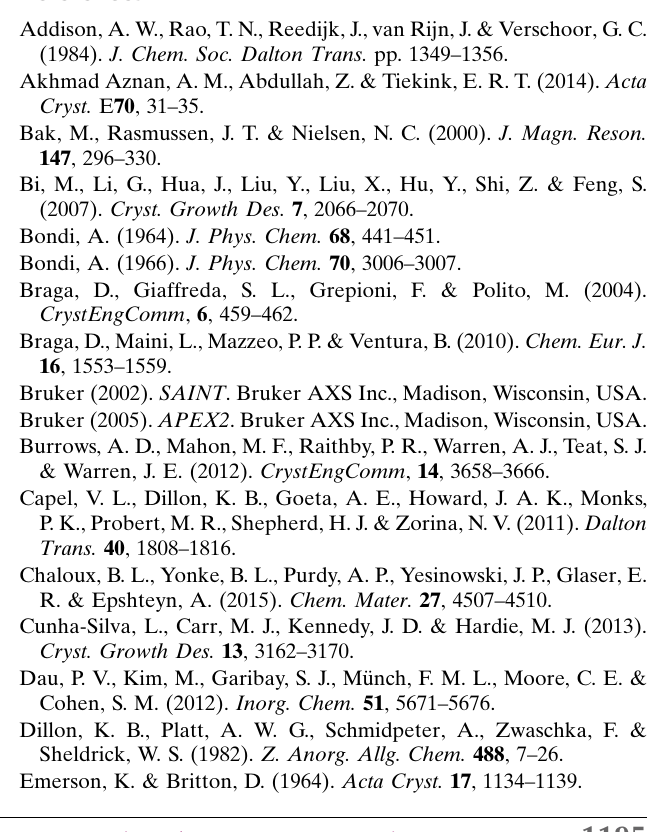
Crystal data Chemical